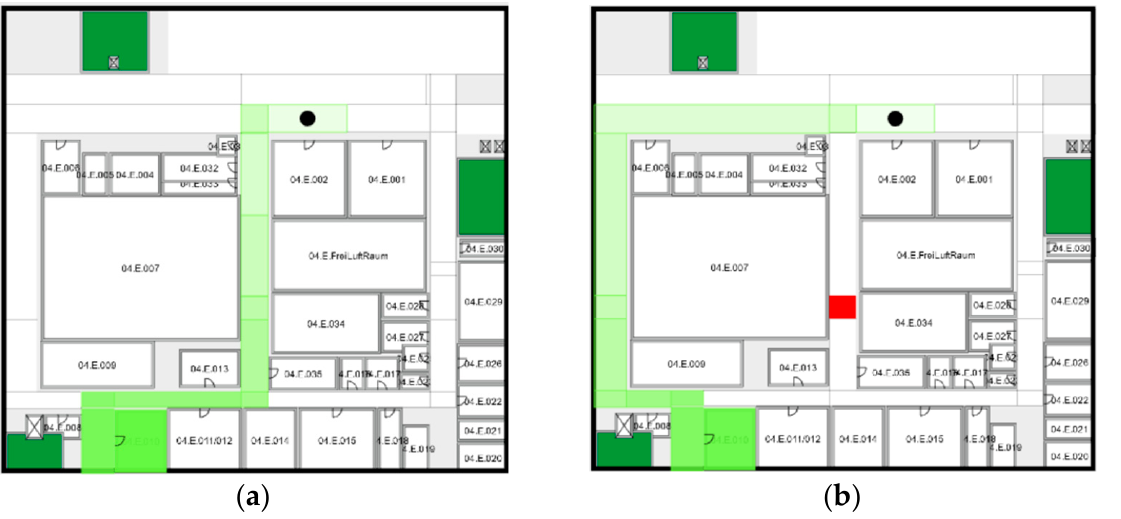
Figure 5. Navigation panel of the app without ( a ) and with areas of high person density ( b ) marked in red.